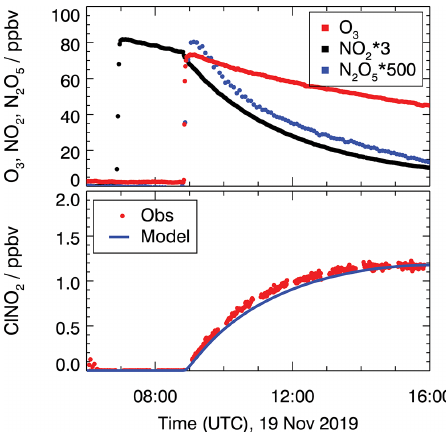
Figure 1. Chamber experiment to characterize ClNO 2 produc- tion from N 2 O 5 conversion on the chamber wall in the dark on 19 November 2019. ClNO 2 concentrations are compared to model calculations and take conversion from N 2 O 5 to ClNO 2 (Reac- tion R6) into account. A reaction rate constant of 8.2 × 10 − 6 s − 1 is required to reproduce measured ClNO 2